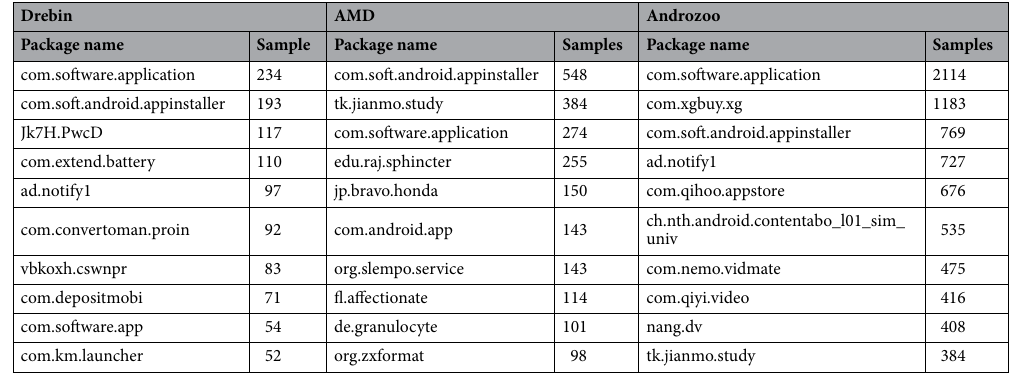
Table 5. Top 10 most reused packages in